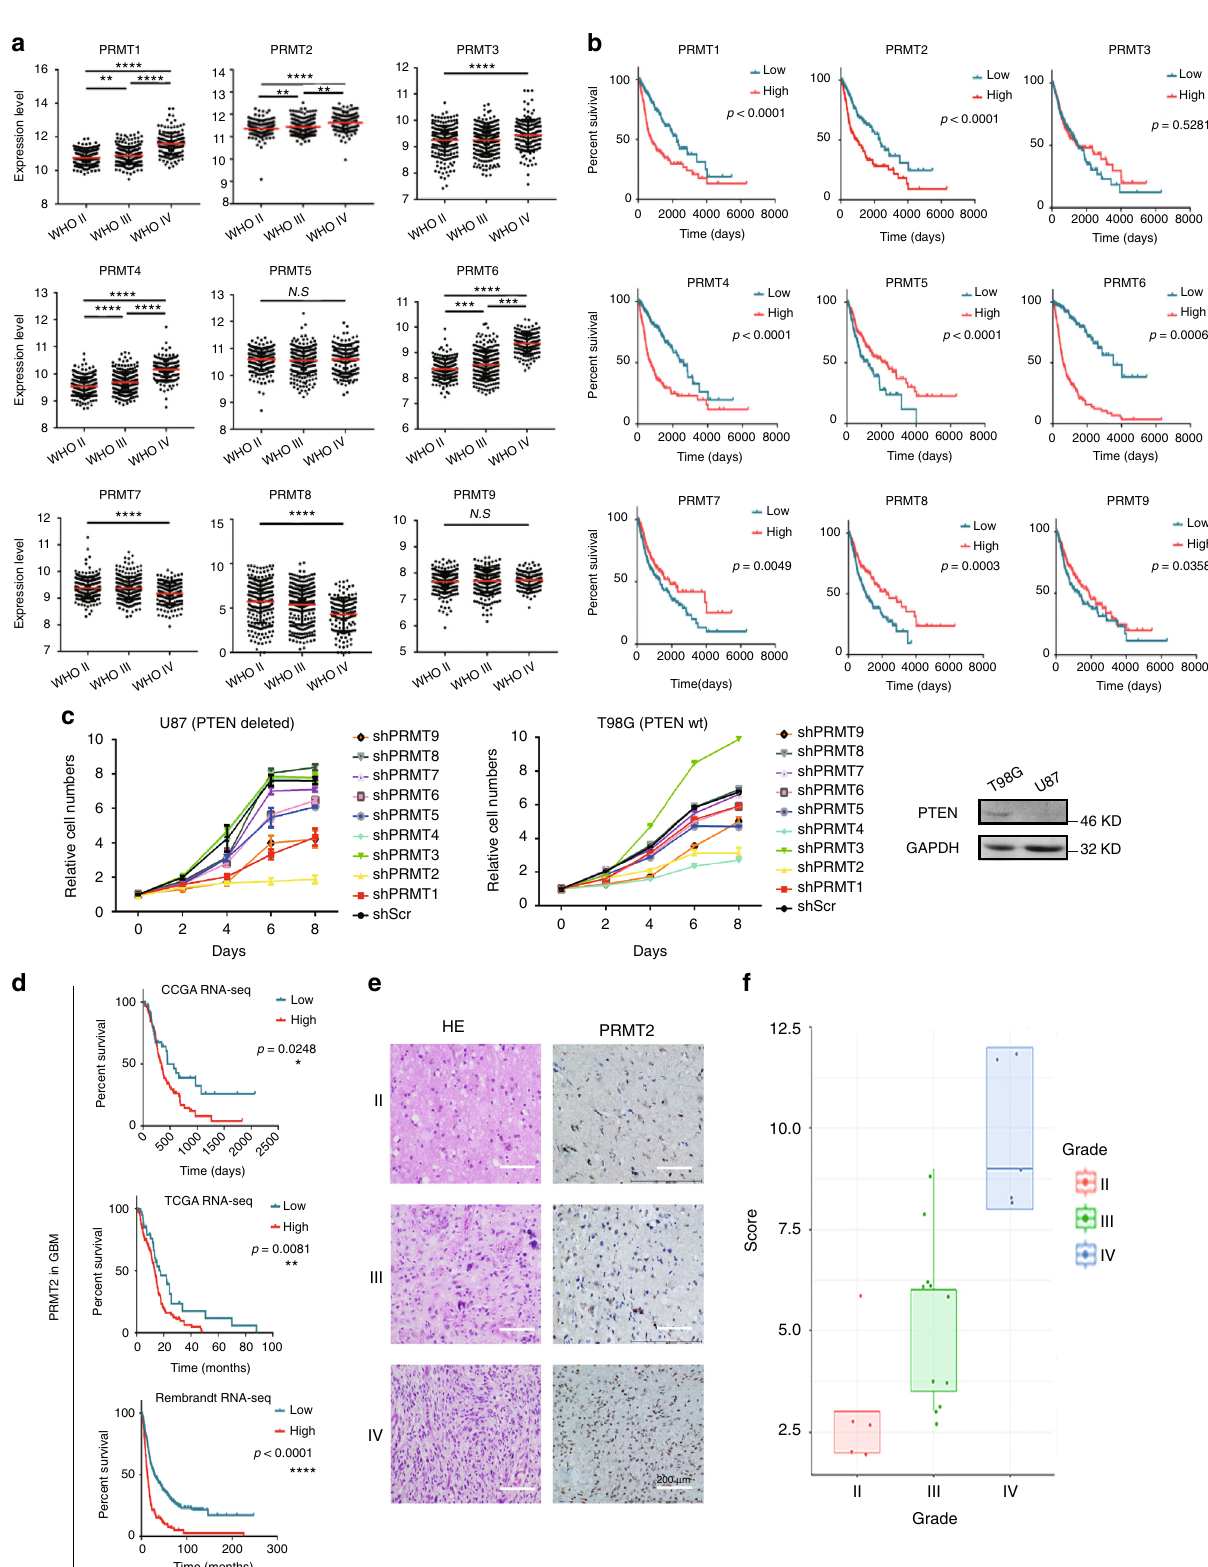
PRMT2 depletion does not trigger cellular apoptosis as detected by fl ow cytometry analysis of Annexin-V-stained U87 cells (Supple- mentary Fig. 3a and b, and see Supplementary Methods). To avoid the bias of immortalized GBM cell lines cultured in serum medium, we also used two tumor progenitor cell (TPC) lines (TPC1115 and